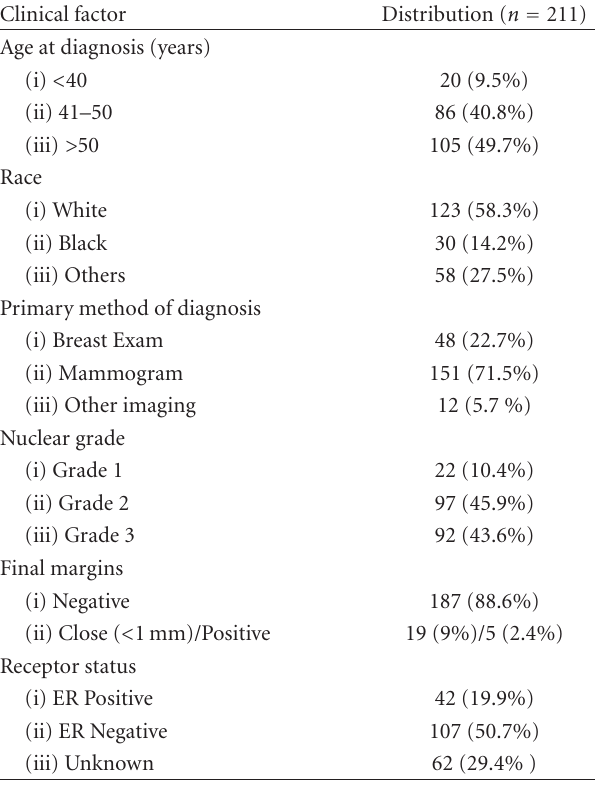
Table 1: Patient characteristics.